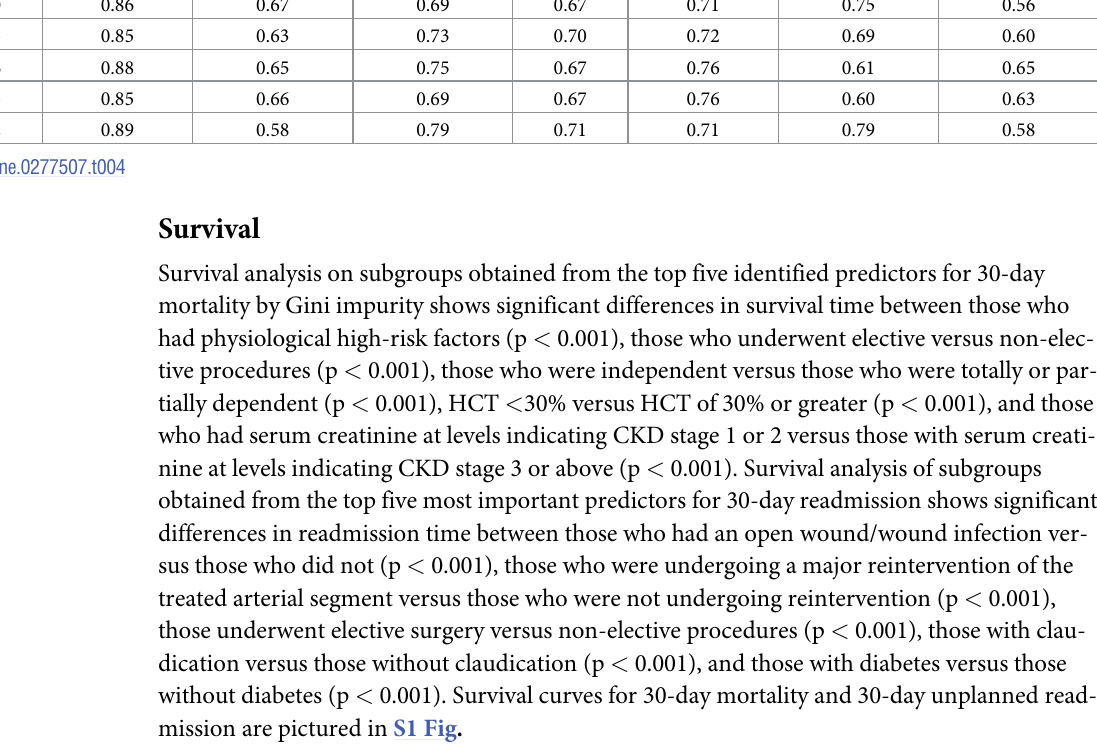
Table 4. AUC, accuracy, sensitivity, and specificity of the random forest models. Mortality